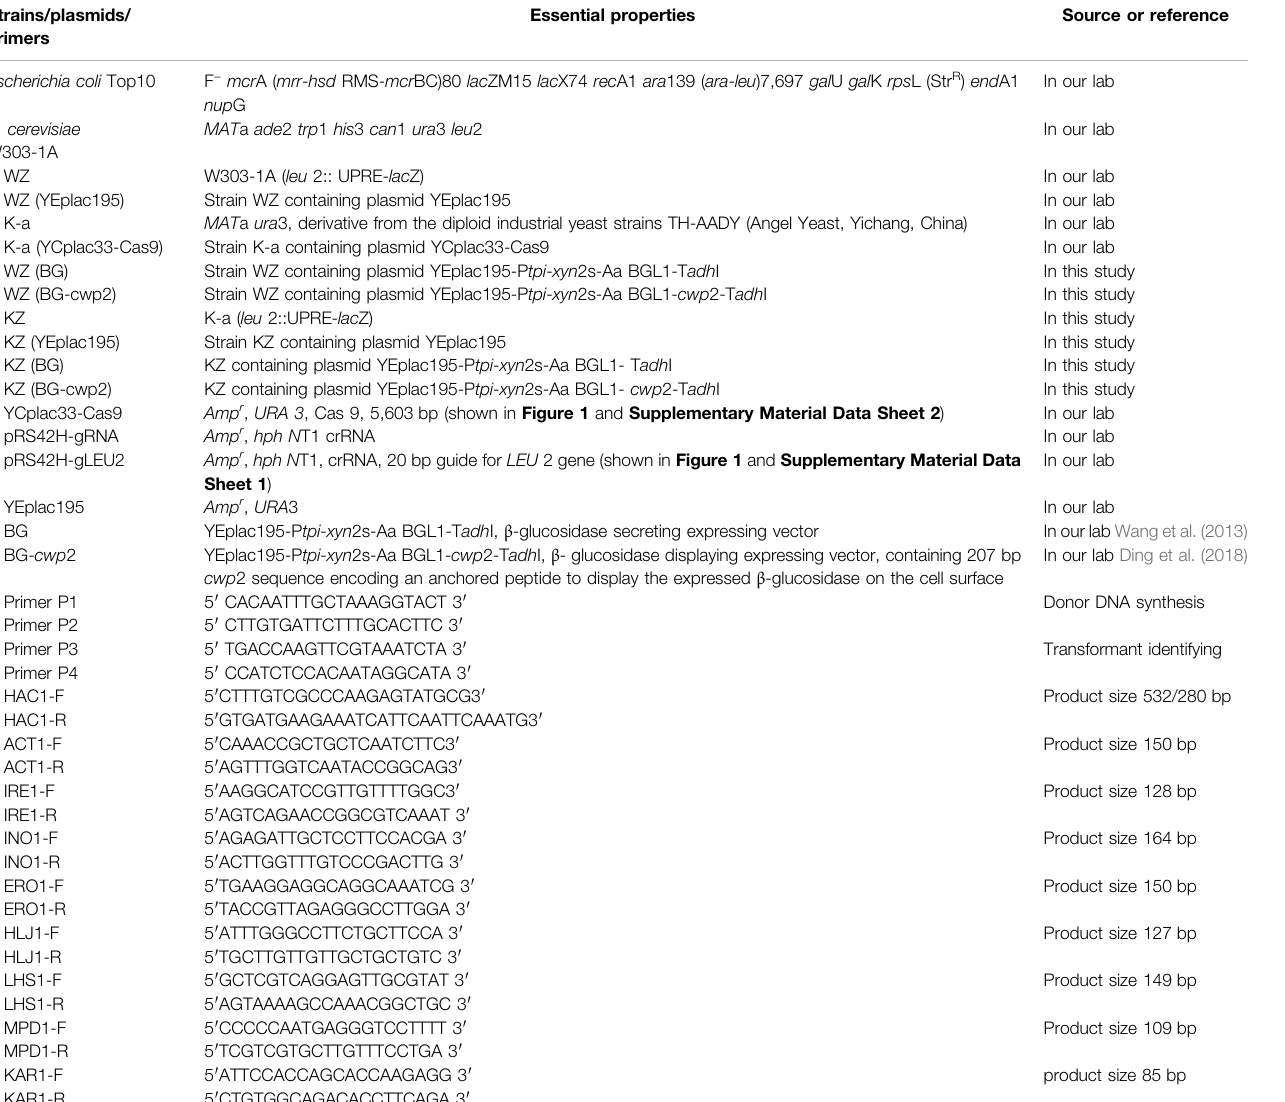
TABLE 1 | Microbial strains, plasmids, and primers used in this study. Strains/plasmids/